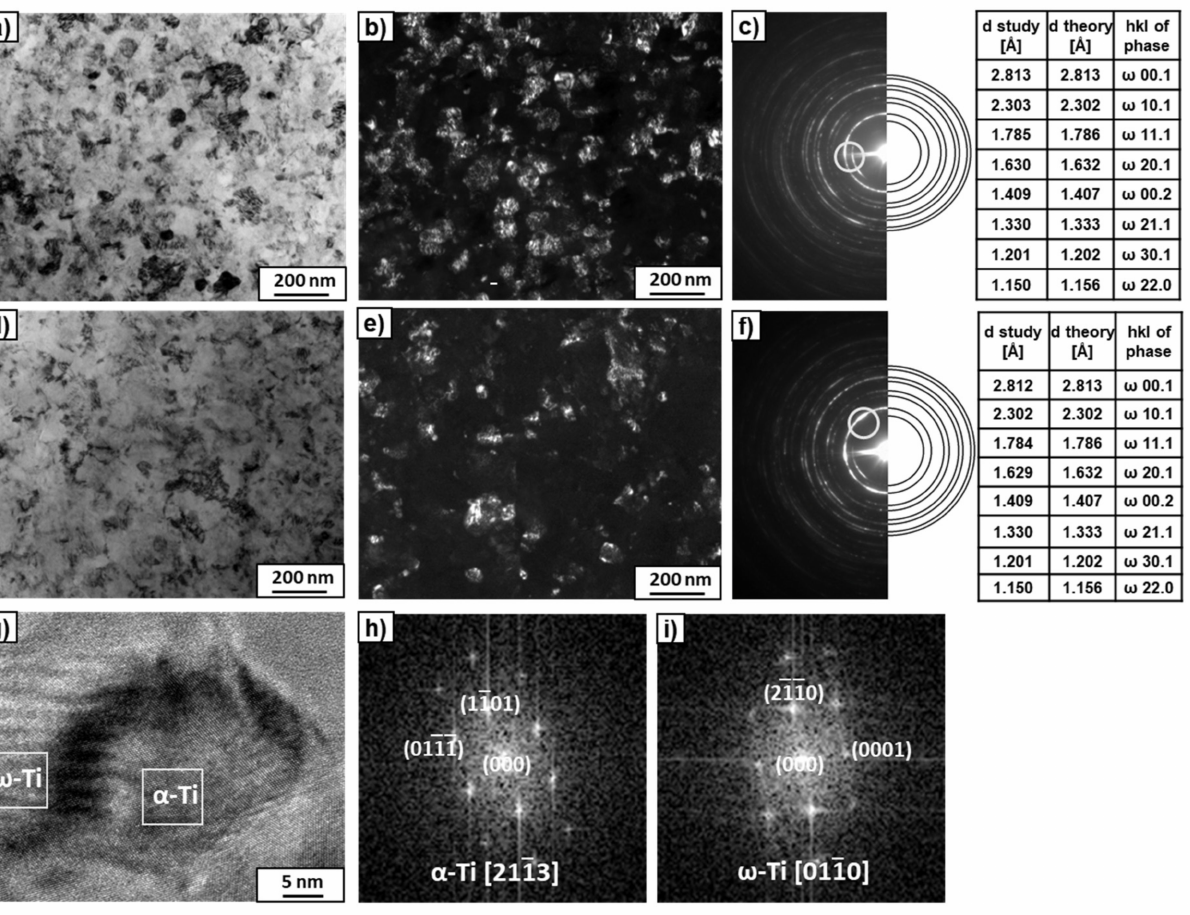
Figure 4. TEM micrographs of the Ti–3wt.% Nb ( a – c ) and Ti–20wt.% Nb ( d – f ) alloys after the HPT process. Bright-field ( a , d ) and dark-field ( b , e ) images and the SAED patterns ( c , f ) with solutions in the tables. The rings in the SAED patterns indicate the position of the objective aperture for obtaining the dark-field images. A high-resolution TEM image ( g ) of the microstructure of the HPT-deformed Ti–20wt.% Nb alloy with fast Fourier transforms (FFTs) obtained from the marked squares for the α -phase ( h ) and ω -phase ( i